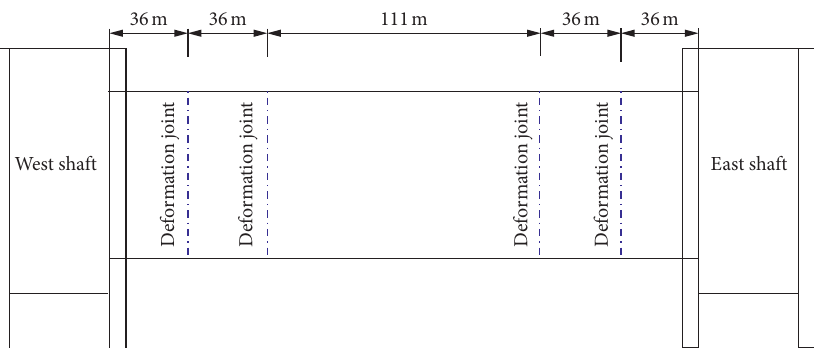
Figure 9: Schematic diagram of the position of the deformation joints in the tunnel excavation section.